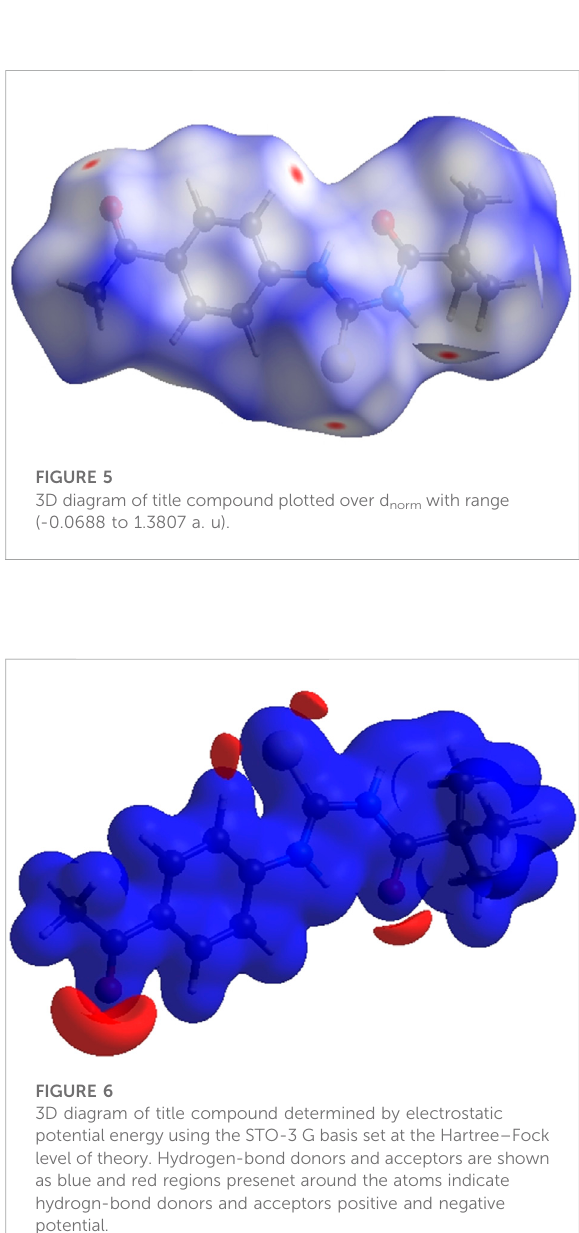
FIGURE 6 3D diagram of title compound determined by electrostatic potential energy using the STO-3 G basis set at the Hartree – Fock level of theory. Hydrogen-bond donors and acceptors are shown as blue and red regions presenet around the atoms indicate hydrogn-bond donors and acceptors positive and negative